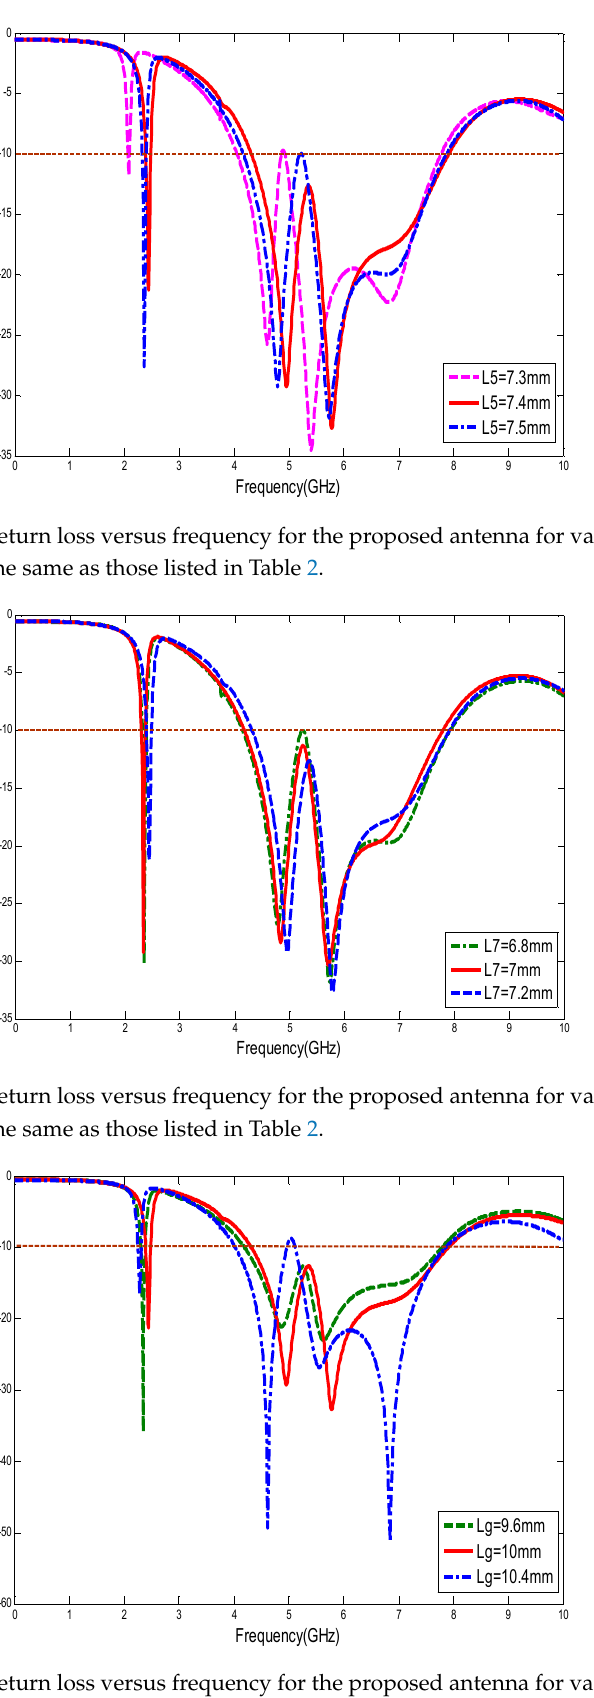
Figure 12. Simulated return loss versus frequency for the proposed antenna for various values of L g ; other parameters are the same as those listed in Table 2.